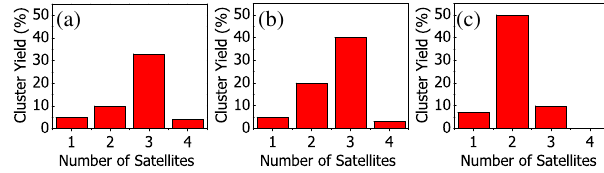
FIG. 3. Normalized incidence of clusters found in a suspension containing positively charged PMMA particles ( σ B ¼ 4025 nm) and locked negatively charged PAM-PMMA particles ( σ A ¼ 1380 nm), (a) without added salt, (b) with 0 . 5 μ M TBAB, and (c) with 1 . 0 μ M TBAB concentration. The complete data including yield of clusters with more than one central particle (typically less than 5% – 10%) are shown in Fig. S1 of SM [50]. Note also that the yield for a certain cluster type is given here by the fraction of the number of observed clusters to the maximum number of that cluster type that could have formed given the total number of central